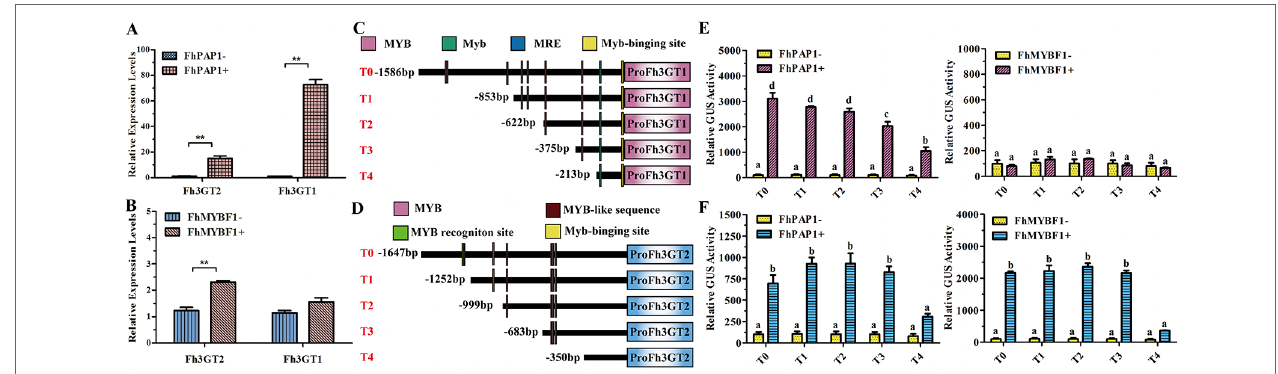
FIGURE 6 | Fh3GT2 and Fh3GT1 were differentially regulated by FhPAP1 and FhMYBF1. (A and B) Relative expressions of Fh3GT2 and Fh3GT1 in Freesia protoplasts transiently expressing anthocyanin-specific FhPAP1 or flavonol-specific FhMYBF1 . (C and D) Schematic diagram of differently truncated Fh3GT promoters and the potential MYB binding sites in the promoter. The predicted MYB binding sites were presented as colorful boxes . (E and F) Promoter activations of Fh3GT2 and Fh3GT1 by FhPAP1 or FhMYBF1. The gene expression levels were quantified by qRT-PCR. The promoter activation abilities by the respective regulators were determined by the relative GUS activities. Data represented the mean ± SD of three replicates. T test was carried out to analyze the significant difference in (A and B) (** P < 0.01). One-way ANOVA was carried out to compare statistical differences in (E and F) (Ducan, P <